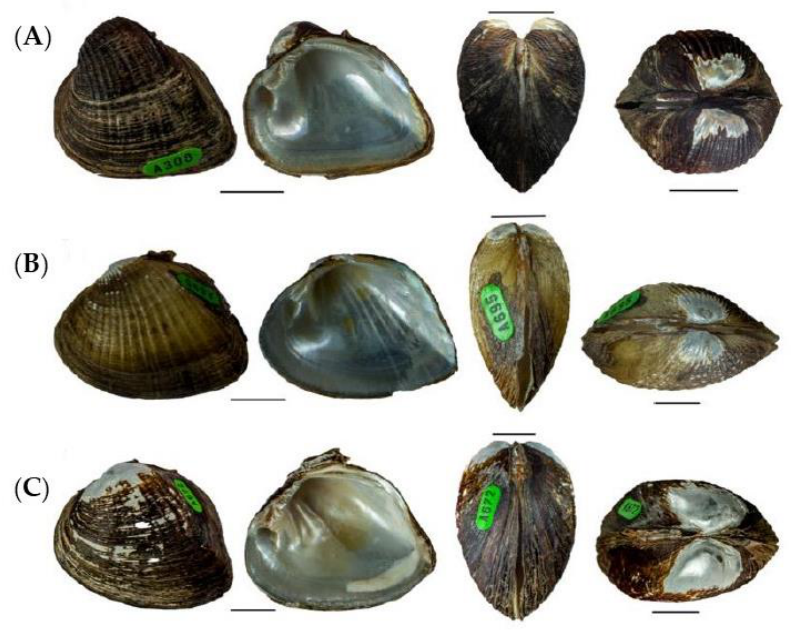
Figure 3. Shell morphologies for representative C. inflata ( A , top row), C. ambigua ( B , middle row), and “ C. ambigua -like” ( C , bottom row). Bars indicate 1 cm.